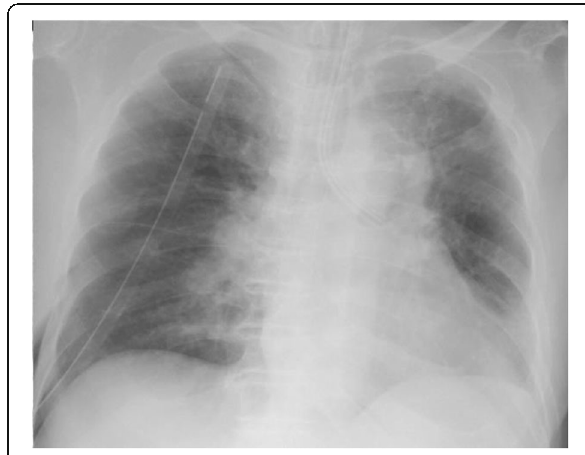
Fig. 2 Chest radiograph after the wedge resection of the lung showing excellent lung